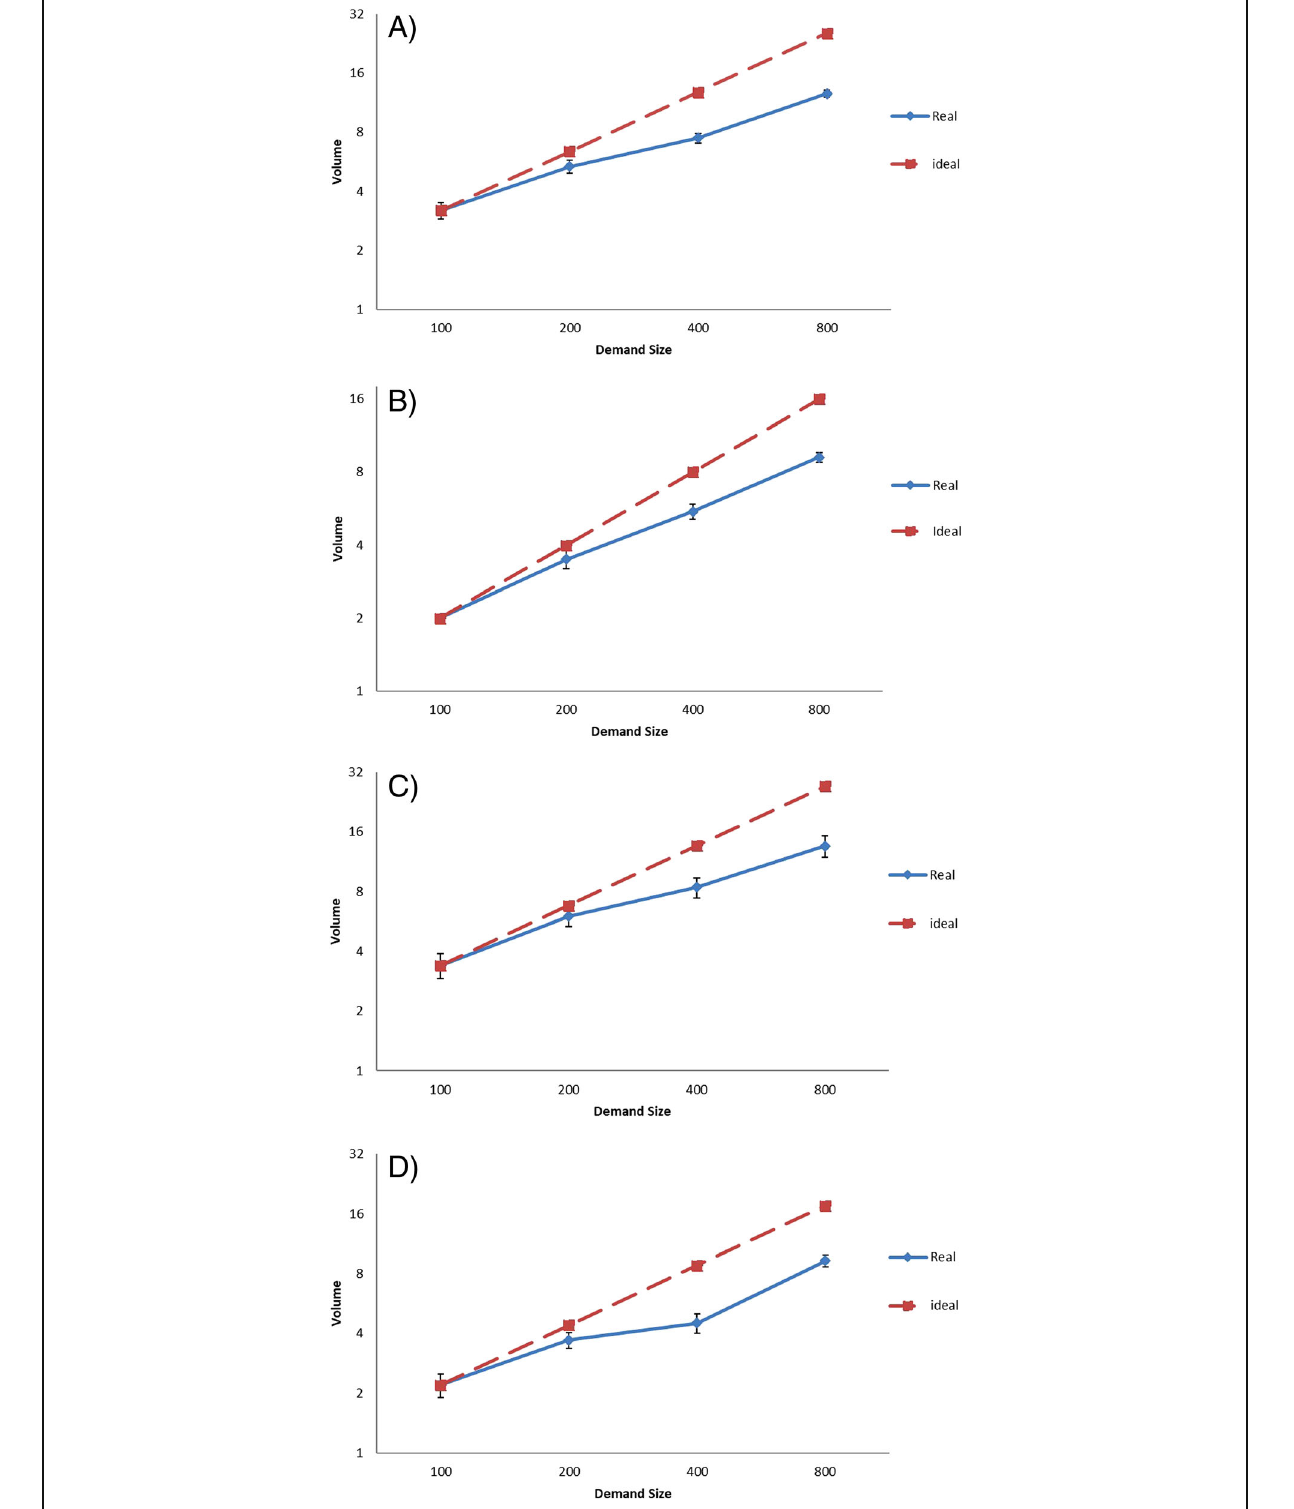
Fig. 6 The average number of software instances. a OrangeHRM/EC2 – Steady rise and fall of demand scenario. b OrangeHRM/Azure - Steady rise and fall of demand scenario. c OrangeHRM/EC2 – Series of step-wise increases and decreases of demand scenario. d OrangeHRM/Azure – Series of step-wise increases and decreases of demand